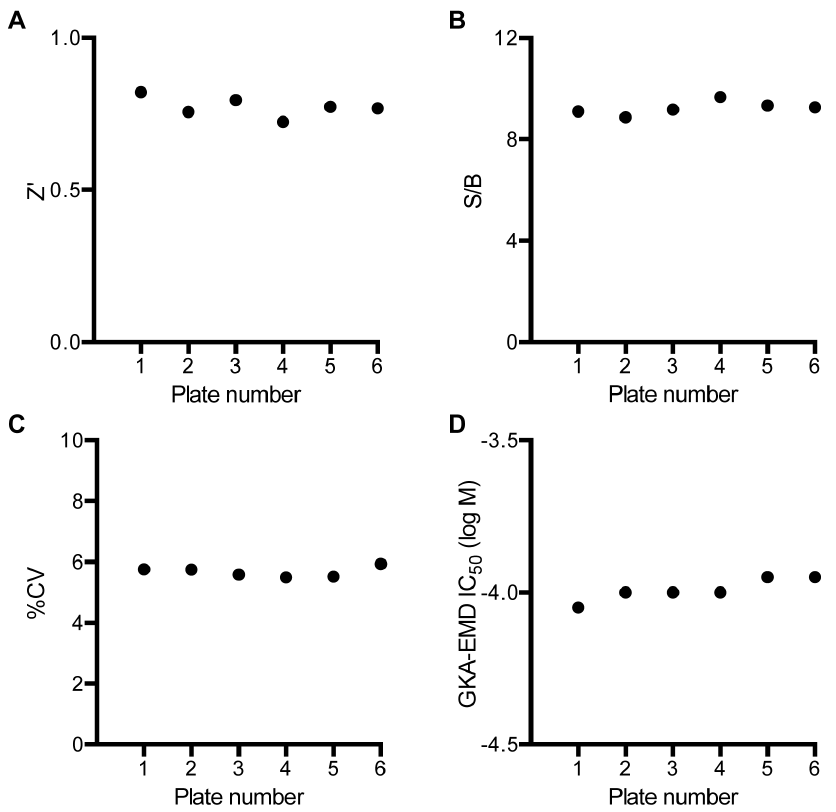
Figure 3. Quality metrics for the HTRF assay with the LOPAC 1280 library in 1536-well plates. (A) Z’ factor, (B) signal/background, (C) % variance, and (D) calculated IC 50 of the control compound GKA-EMD as a function of assay plate.